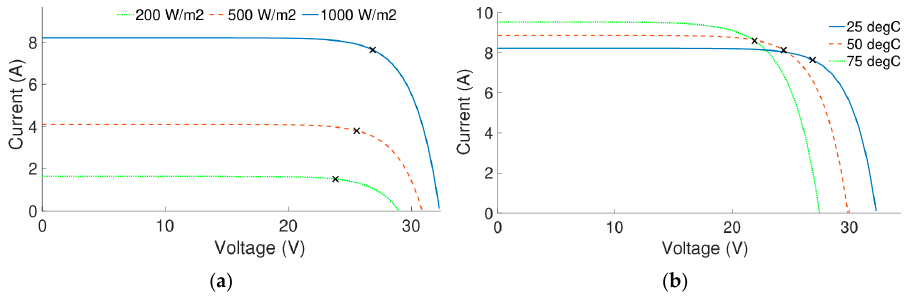
Figure 29. I - V characteristic of the PV cell vs. variation in irradiation ( a ) and temperature ( b ). Based on the used PV technology, different PV cells demonstrate varying conversion efficiencies.